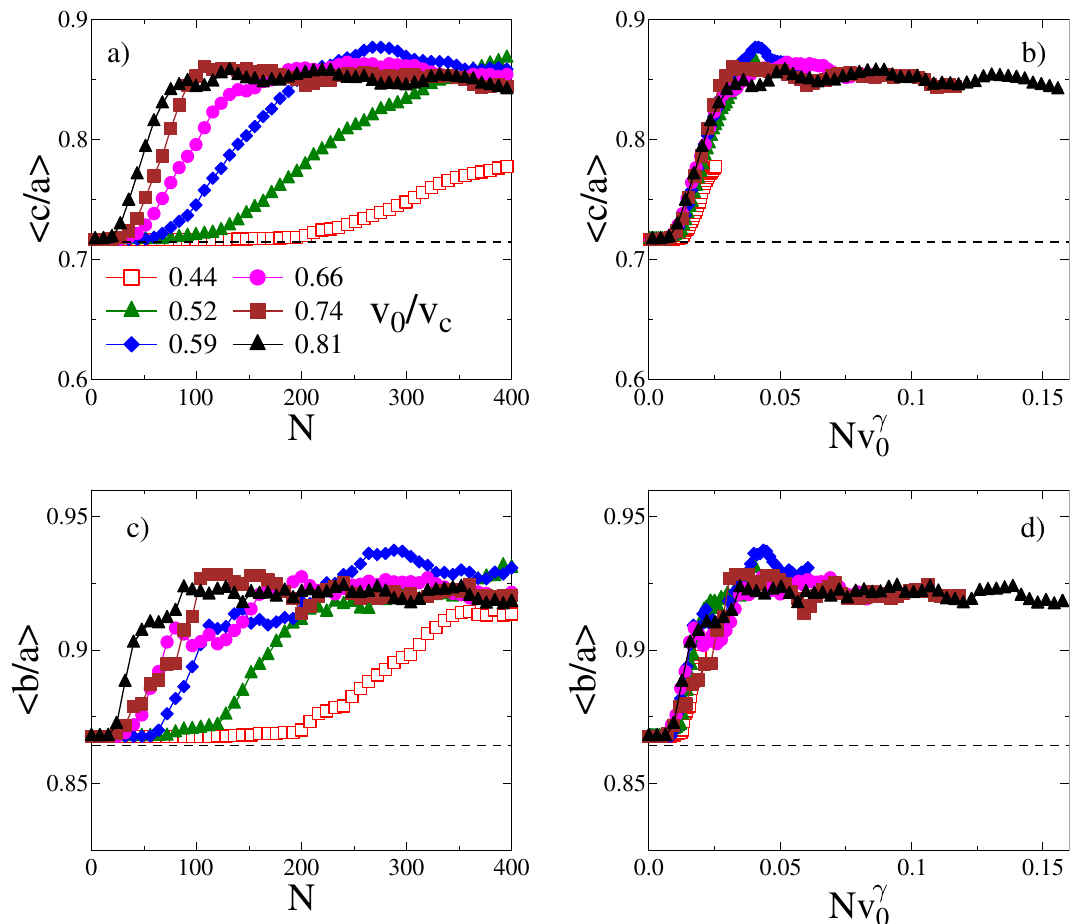
Figure 6. Average side length ratios (cid:31) c / a (cid:30) ( a ) and (cid:31) b / a (cid:30) ( c ) of the bounding box of the residues as function of the impact number N for different impact velocities inside the abrasion energy phase v 0 < v c . The horizontal dashed lines represent the initial values � c 0 / a 0 � = 1 / 1.4 and � b 0 / a 0 � = 1.2 / 1.4 . By rescaling the impact number N in ( b ) and ( d ) by an appropriate power γ of the impact velocity v 0 , the curves of different v 0 of ( a ) and ( c ) can be collapsed on master curves. Best collapse is achieved using the same exponent γ = 3 in ( b ) and ( d